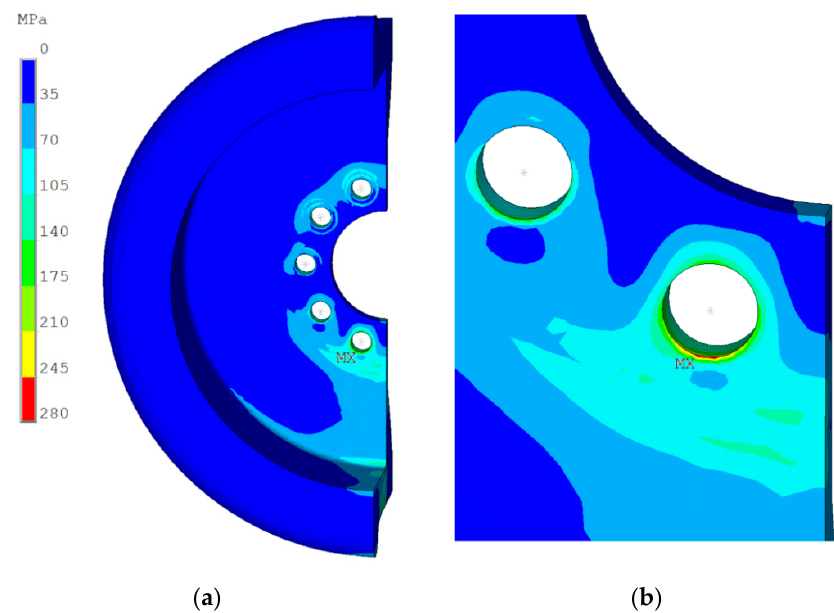
Figure 10. Von Mises stress distribution for the optimal rail wheel geometry made of 42CrMo4 steel. ( a ) View of the entire model; ( b ) view of the stress concentration point.